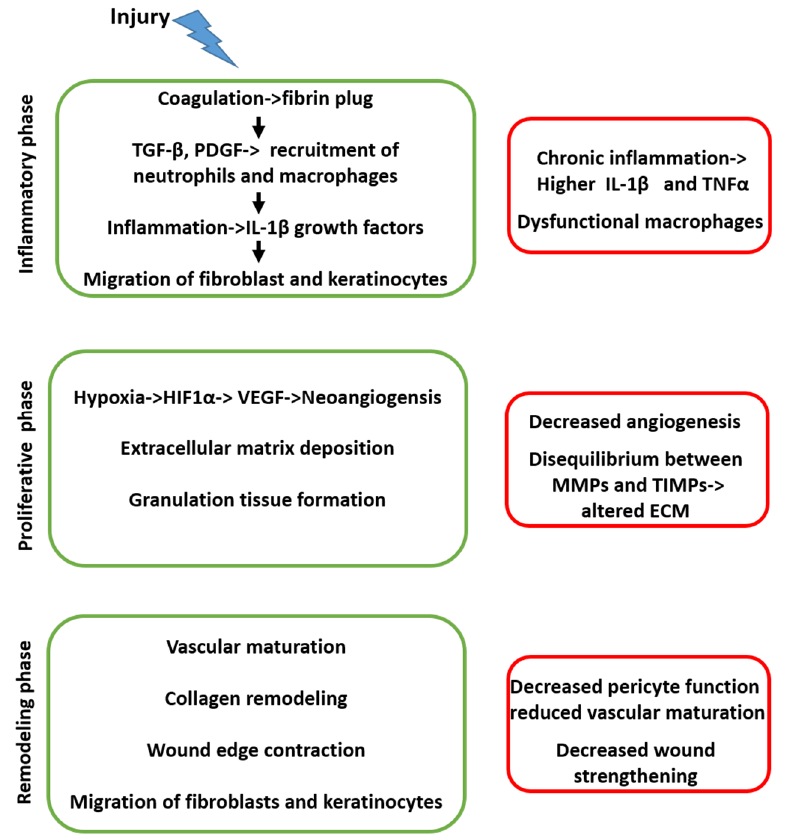
Figure 1. The series of events that occur in sequence during physiological (left side, green) and diabetic (right side, red) wound healing. (right side, red) wound